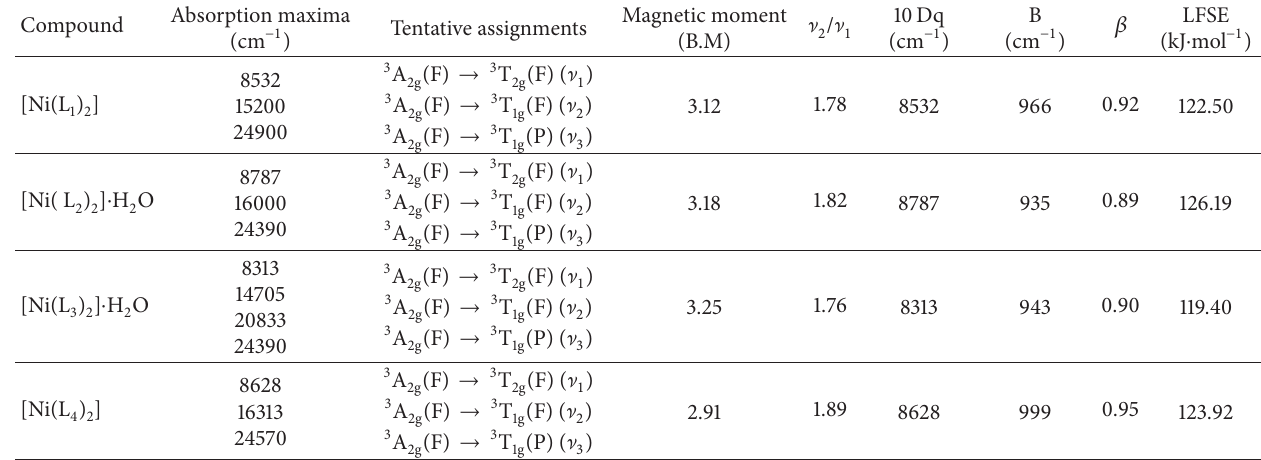
Table 3: Electronic, magnetic, and ligand field parameters of Ni(II) complexes.